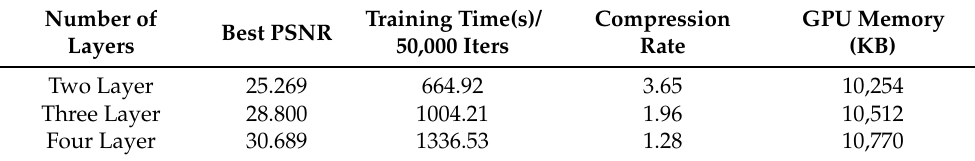
Figure 9. Results of the whole procedure of our architecture. From the left, the first image shows the original high-resolution (HR) image. The second shows the original low resolution (LR). The third image shows the reconstructed low resolution (LR) and the last shows the reconstructed high resolution (HR). The best PSNR of reconstructed HR in comparison with the original HR is 35.140. Table 5. Shows comparison results of the implementation of SIREN without our architecture in terms of quality, speed, GPU memory allocation, and compression rate with 2, 3, and 4 layers with